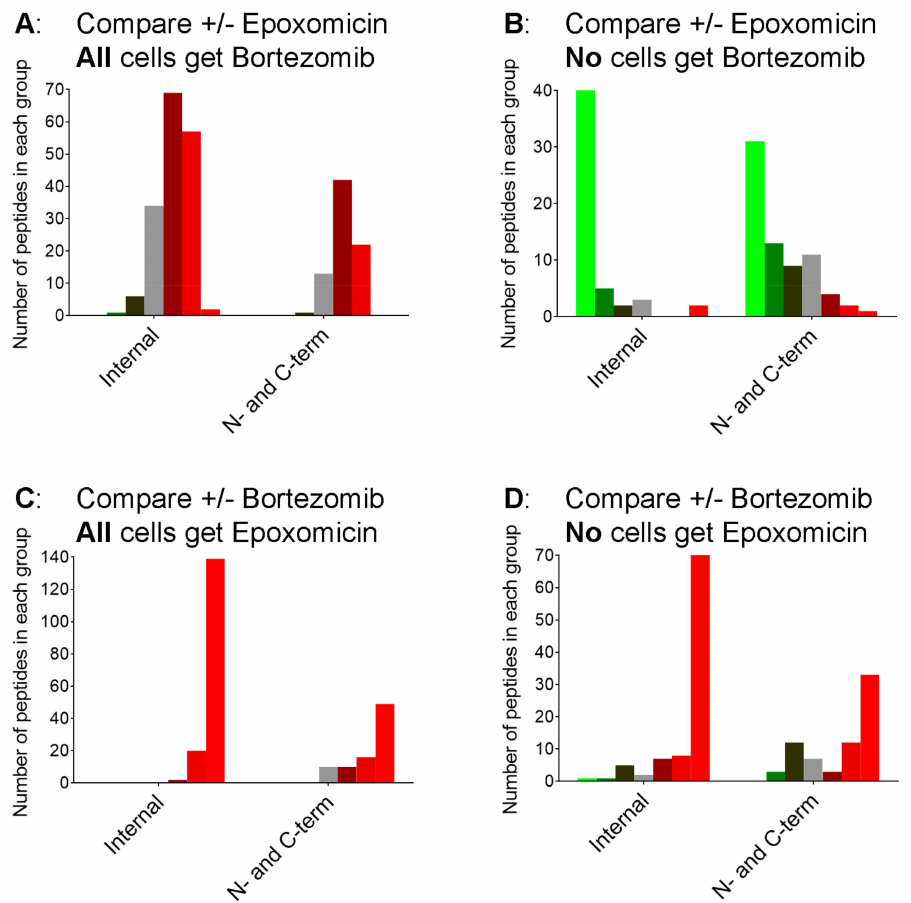
Figure 7. Correlation of the e ff ect of proteasome inhibitors with the location of the peptide within the protein precursor. The N-terminal group includes peptides lacking the initiation Met. Cells were treated as described in Figure 4 and color coded as described in Figure